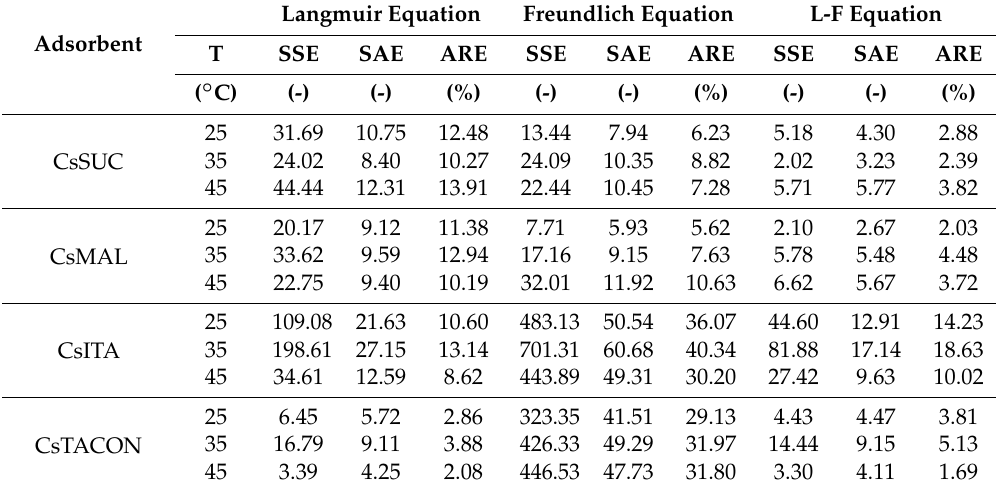
Table 3. Values of three different error analyses of isotherm models for adsorption of DCF onto chitosan derivatives.